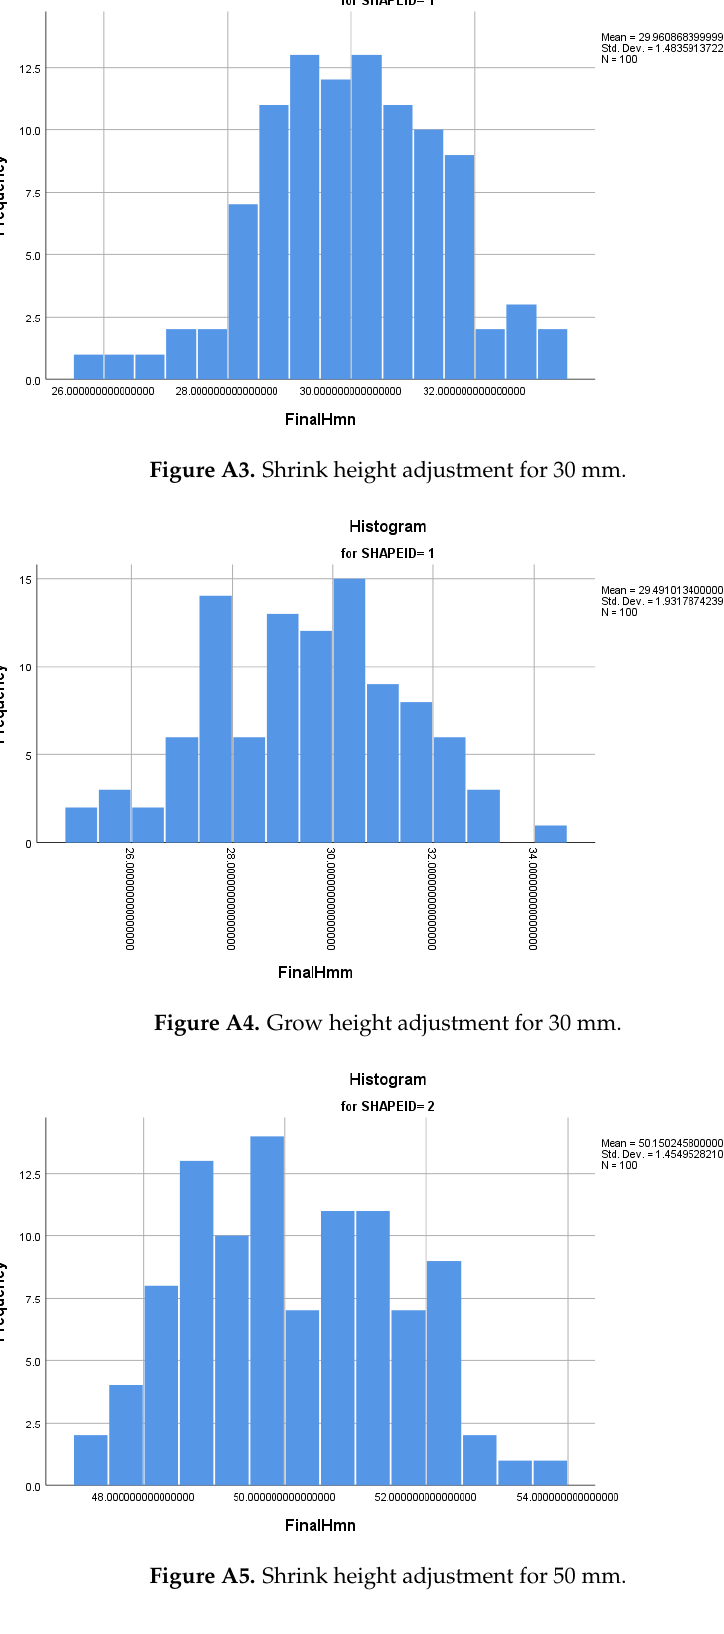
Figure A5. Shrink height adjustment for 50